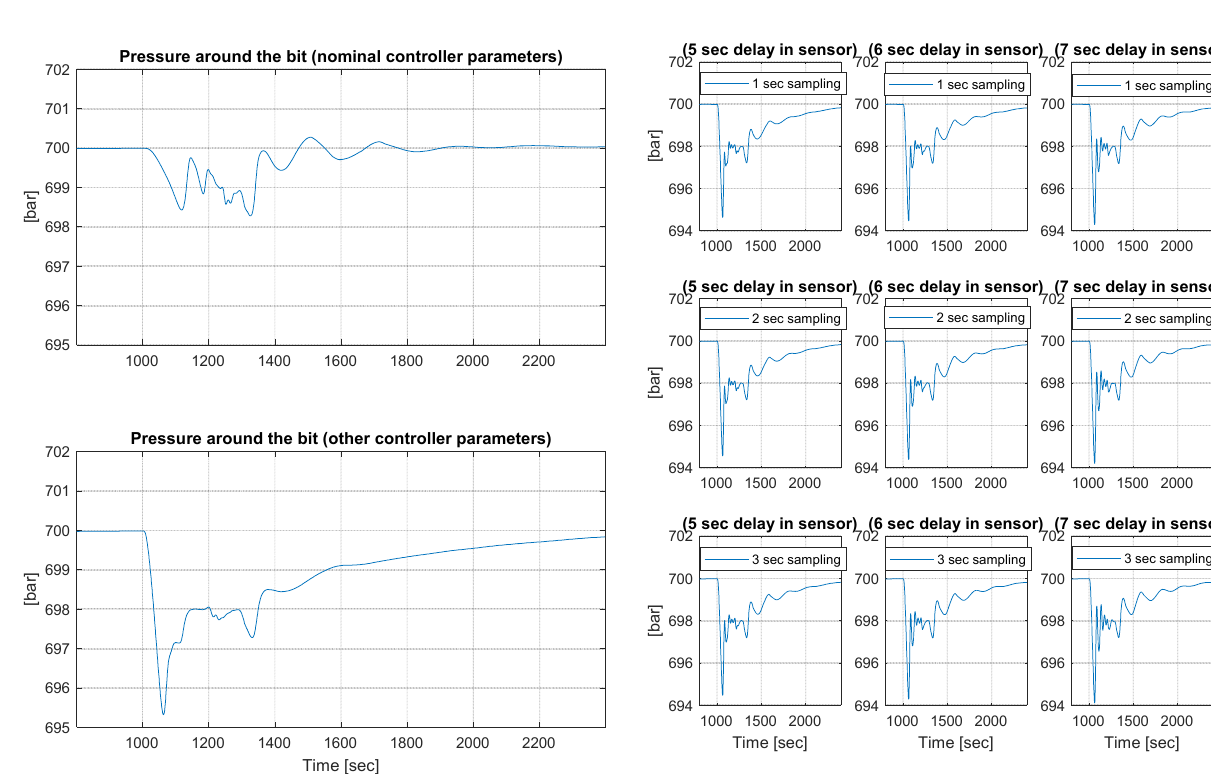
Figure 11: Pressure response which is robust w.r.t. delay in measurement and different sam- pling times (using other (robust) controller